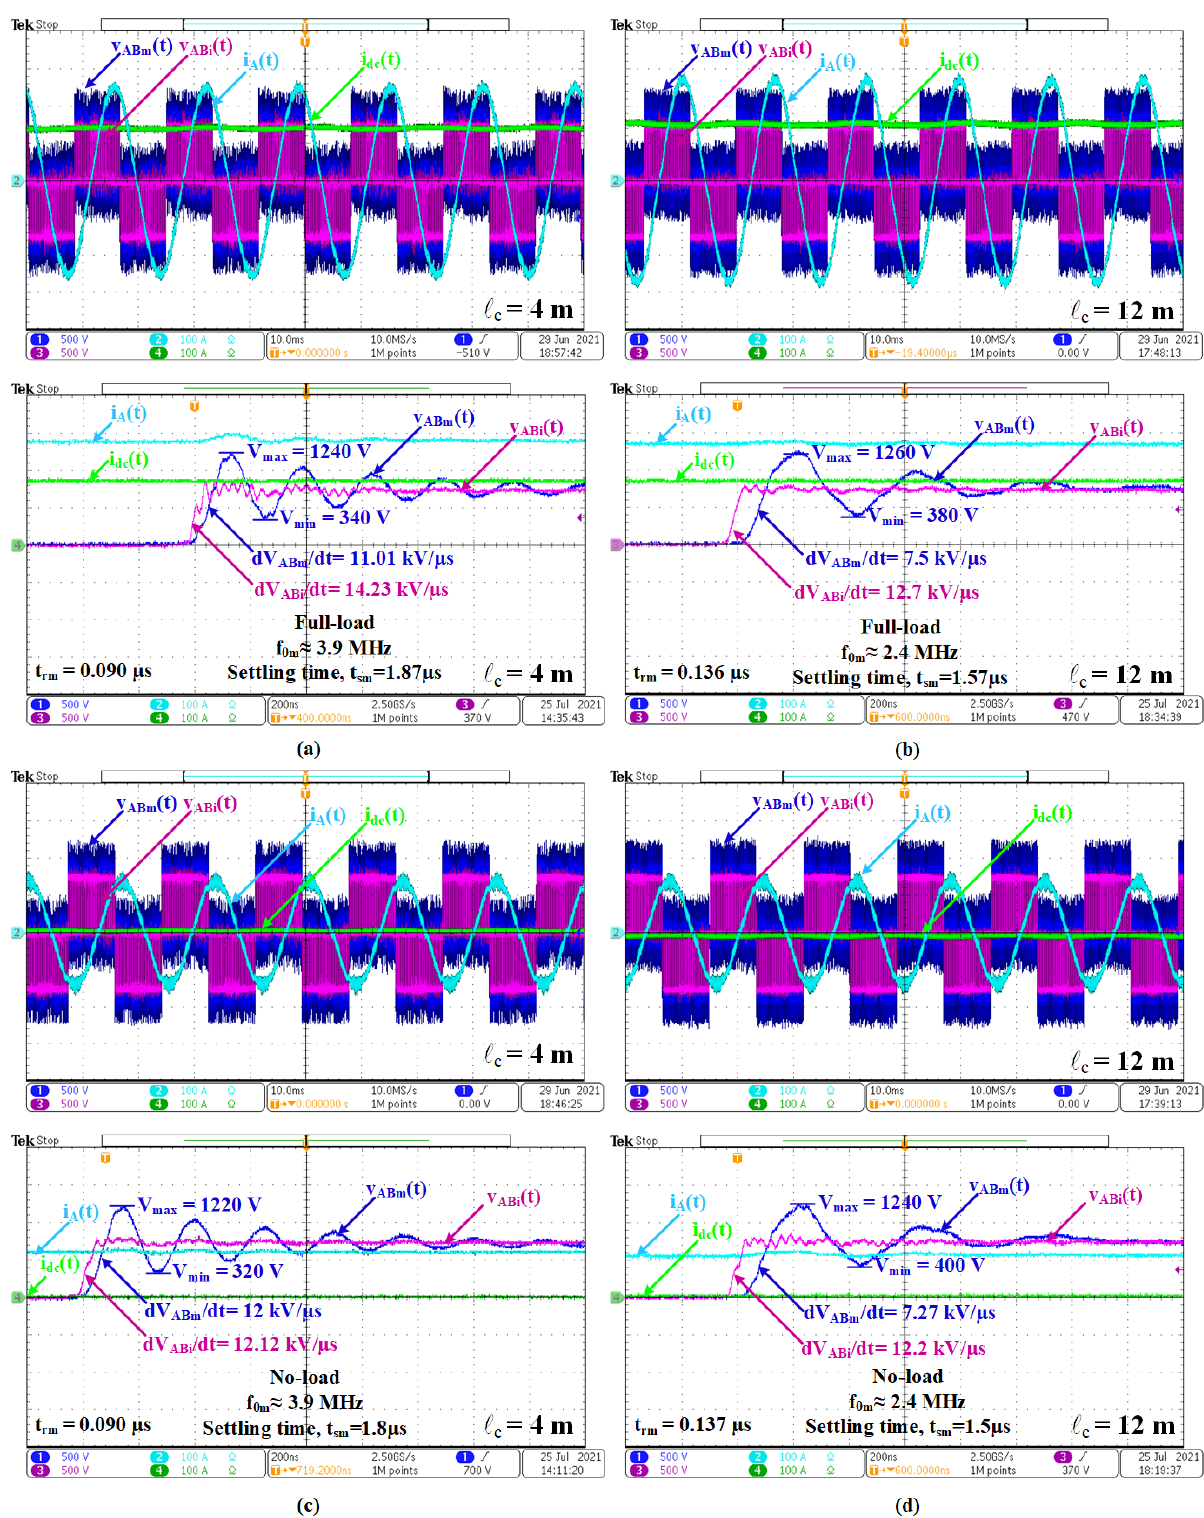
Figure 25. Effects of motor cable length on line-to-line motor voltages. ( a ) 4 m cable length at full load, ( b ) 12 m cable length at full load, ( c ) 4 m cable length at no load, ( d ) 12 m cable length at no load.